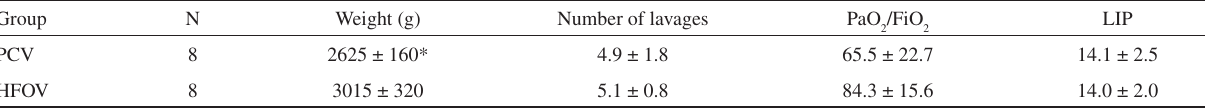
PCV: Protective conventional ventilation; HFOV: High frequency oscillatory ventilation; LIP: Lower inflexion point of PV-curve. *p <